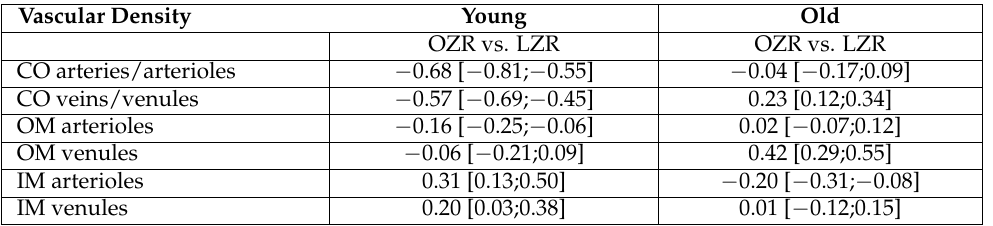
Table 3. Comparison of renal vascular density between lean Zucker rats (LZR) and obese Zucker rats (OZR) at the age of 11 and 20 weeks.